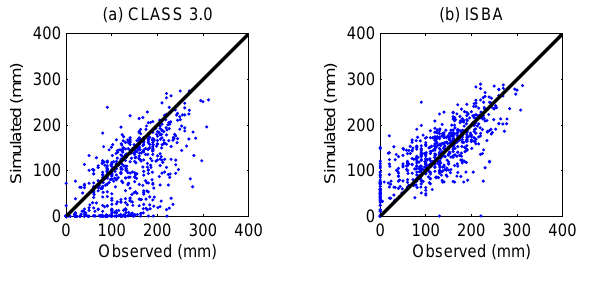
Fig. 14. Verification of MESH SWE predictions against snow sur- vey observations.